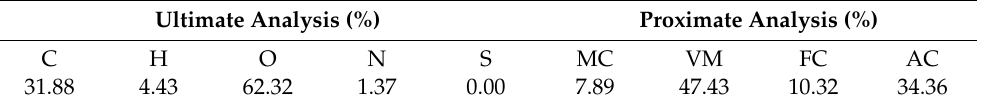
Table 1. Properties of yak